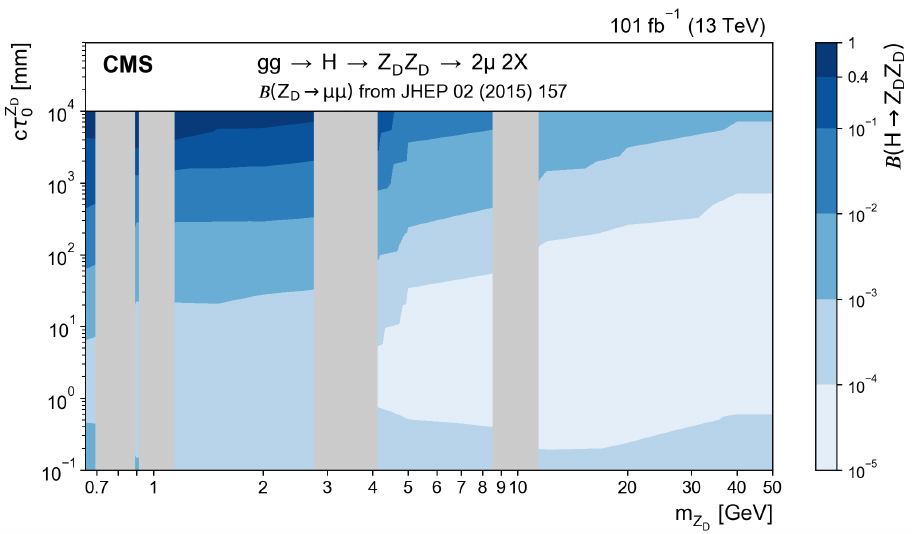
Z ) as contours in the D D ) and the signal lifetime cτ Z D for the H → Z Z Z D D D 0 → mm ) from the model of ref. [6]. The vertical gray bands D